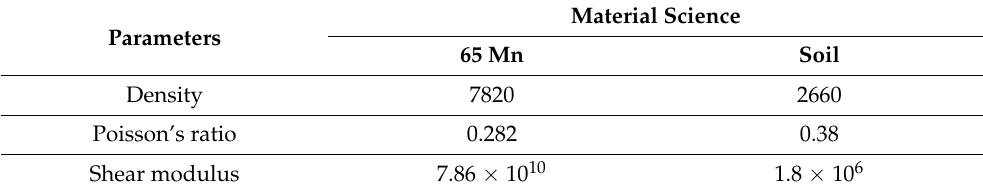
Table 1. Material parameters.